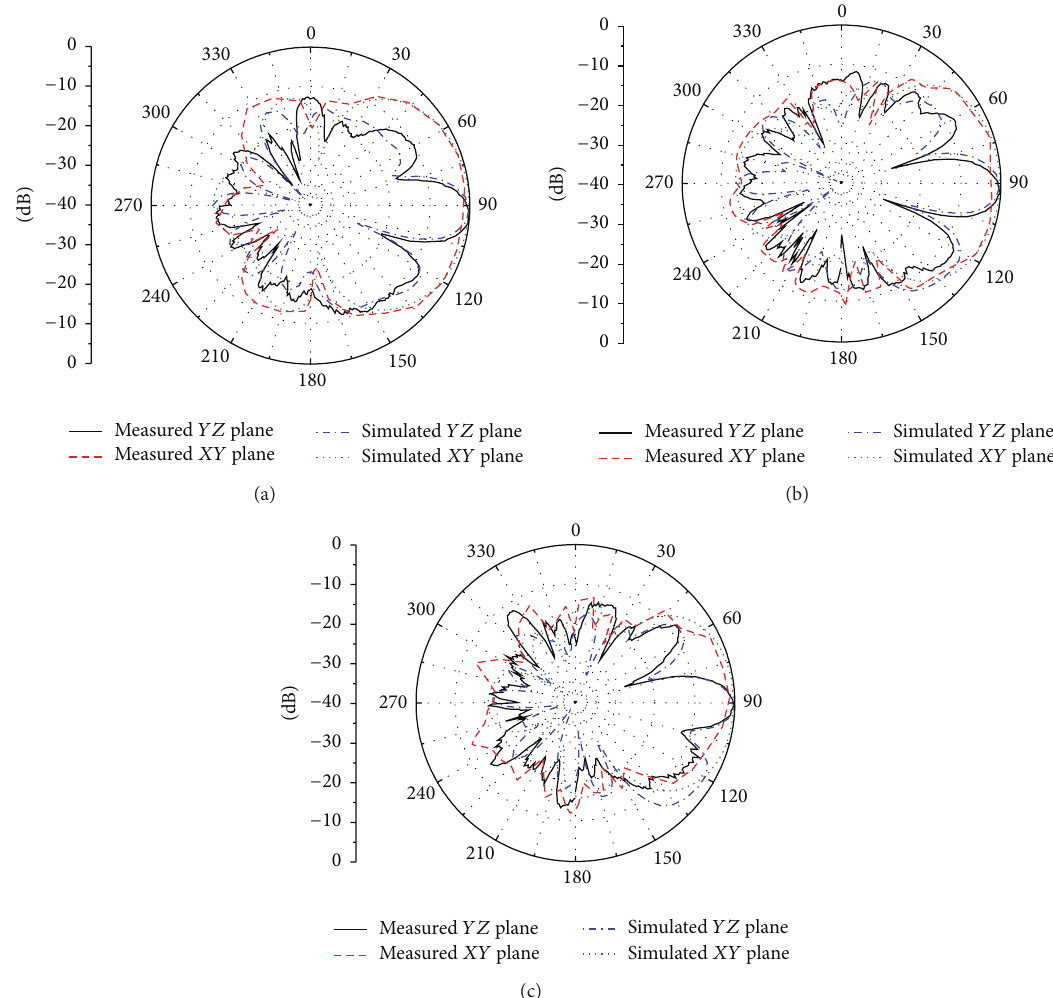
Figure 9: Normalized measured and simulated radiation patterns of array at (a) 5GHz, (b) 6 GHz, and (c) 7GHz.